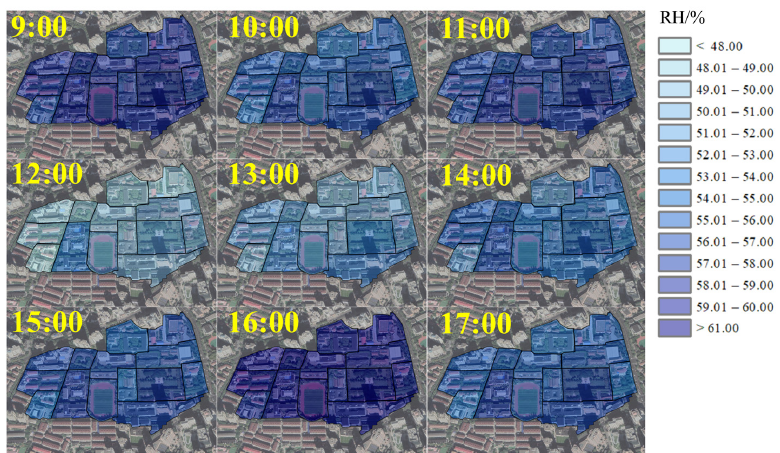
Figure A2. Hourly relative humidity maps in the university campus region.